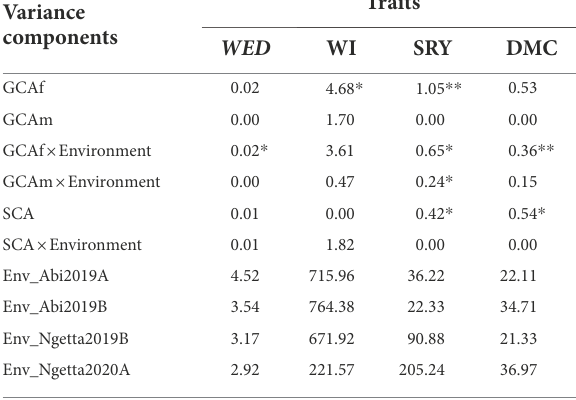
TABLE 4 Variance components and likelihood ratio test results for general combining ability (GCA) and specific combining ability (SCA) effects for weevil severity (WED, scale 1–9), weevil incidence (WI, %), storage root yield (SRY, t/ha), and dry matter content (DMC, %) across four environments.